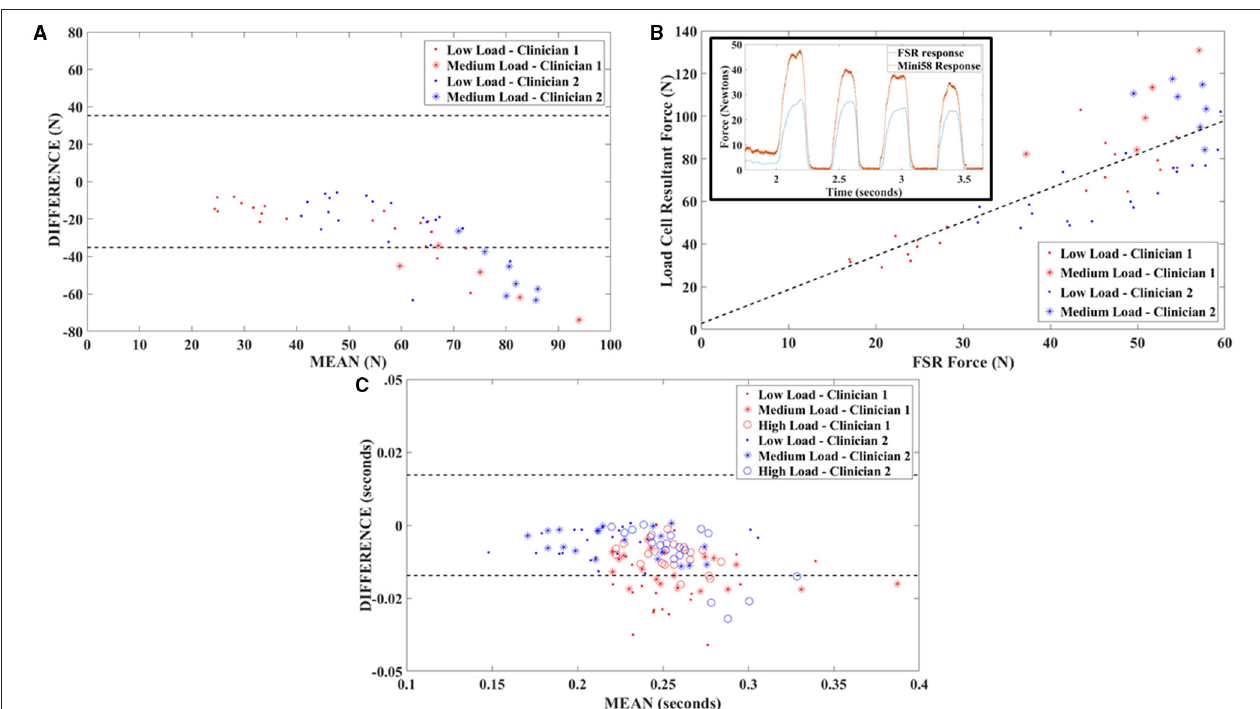
FIGURE 2 | Validation testing outcomes. (A) Bland-Altman plot of FSR validation testing data showing a proportional bias between FSR output and gold standard (six-axis load cell) force measurements. Dashed lines indicate ± 1.96 SDs. (B) Correlation plot for FSR and gold standard output with best fit line obtained through least squares linear regression. The insert depicts time series data and illustrates responsiveness of the FSR sensors. (C) Bland-Altman plot of FSR validation testing data showing a small offset bias between FSR output and gold standard (six-axis load cell) load duration measurements. Dashed lines indicate ± 1.96